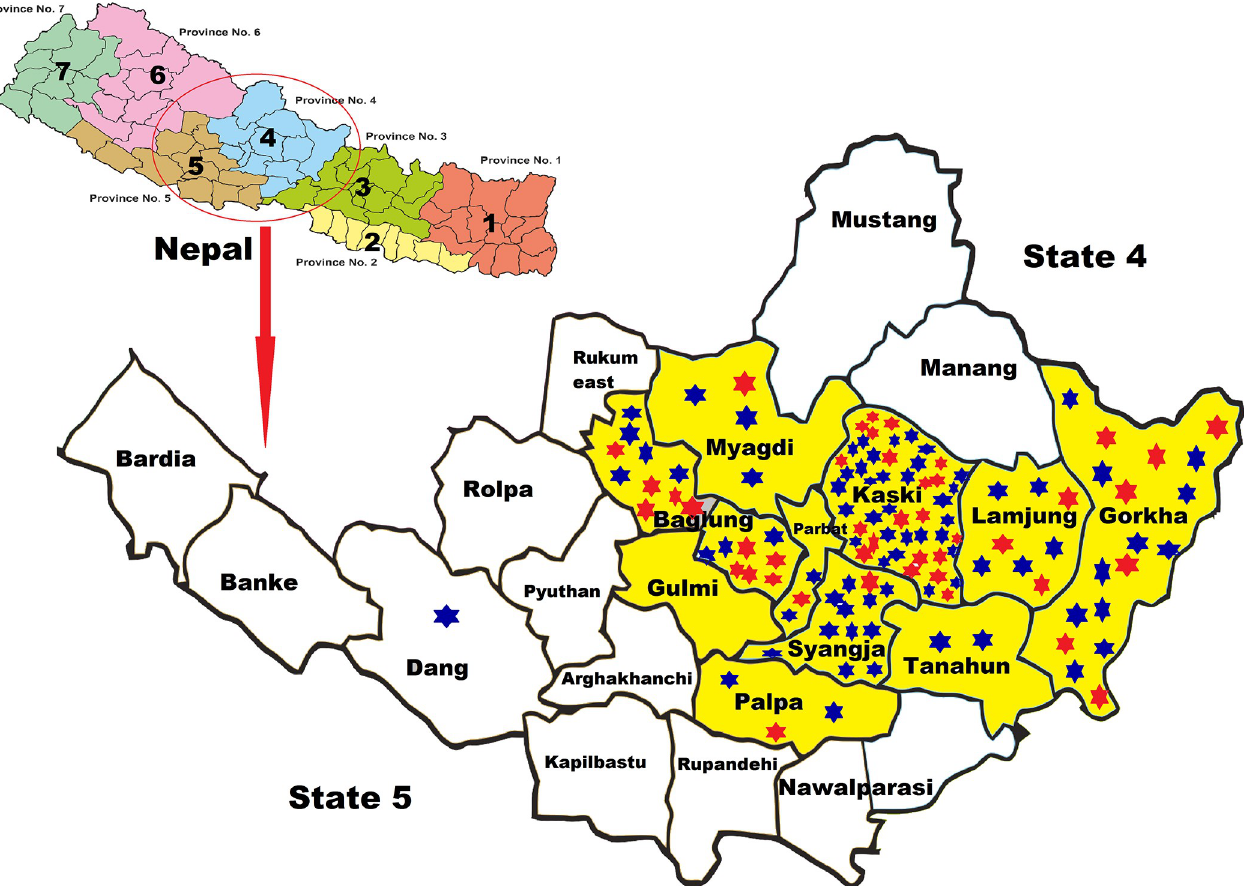
Fig 1. Location of 2 States (4 and 5) of Nepal where samples were collected. (The star indicates samples from HPLWH, Blue star- ESBL negative and Red star- ESBL positive. Yellow area indicates samples collected from HIV sero-negative population in the community). Map source: https://commons.wikimedia.